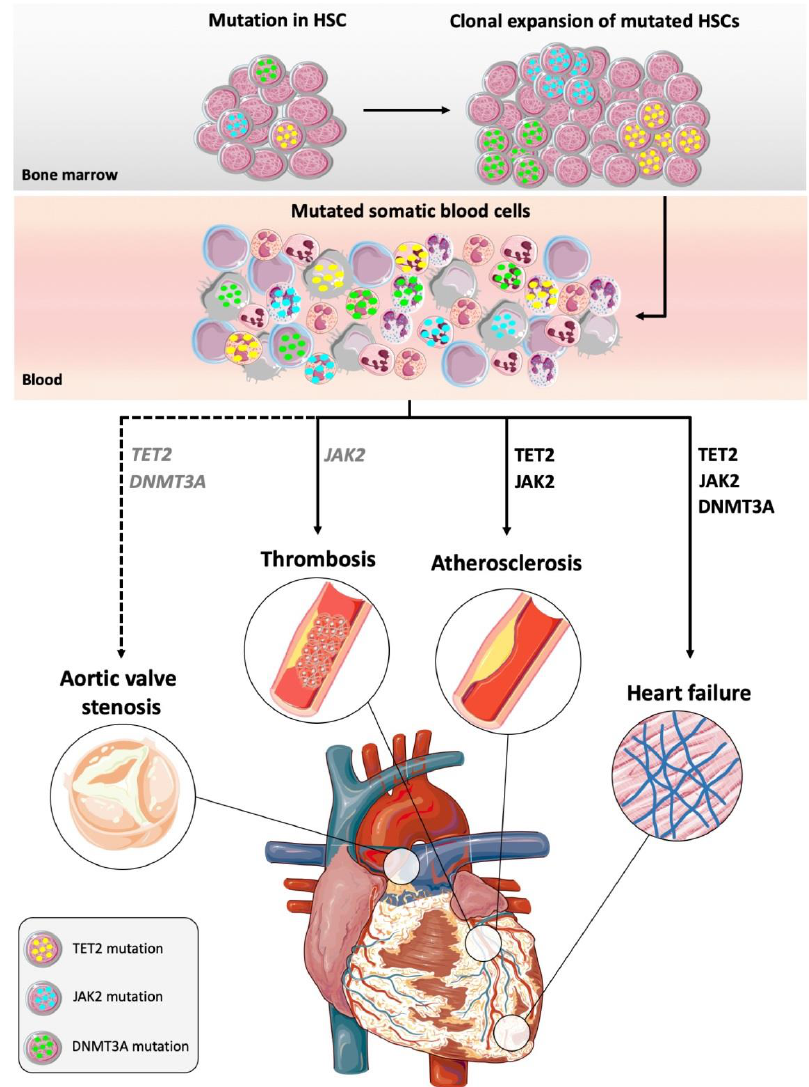
Figure 1. Clonal hematopoiesis of indeterminate potential (CHIP) causes cardiovascular disease. Mutations can confer a selective advantage to a hematopoietic stem cell (HSC) that leads to clonal expansion of the mutated HSC, which can give rise to a significant proportion of clones of mutated somatic blood cells. TET2 and JAK2 mutations preferentially involve myeloid cells. DNTM3A mutations are present in somatic blood cells of both myeloid and lymphoid origin. Mutations in the genes TET2, DNMT3A and JAK2 (in black) are associated with increased cardiovascular risk in epidemiological studies, and they have been causally implicated in cardiovascular diseases in animal models. TET2 and DNMT3A mutations (in grey italic) are enriched in aortic valve stenosis, but causality has not been established yet (indicated with dashed lines). JAK2 (in grey italic) hyperactivation is associated with thrombosis in CHIP patients; causality between JAK2 mutations and thrombotic diseases has been established in an animal model of myeloproliferative neoplasm